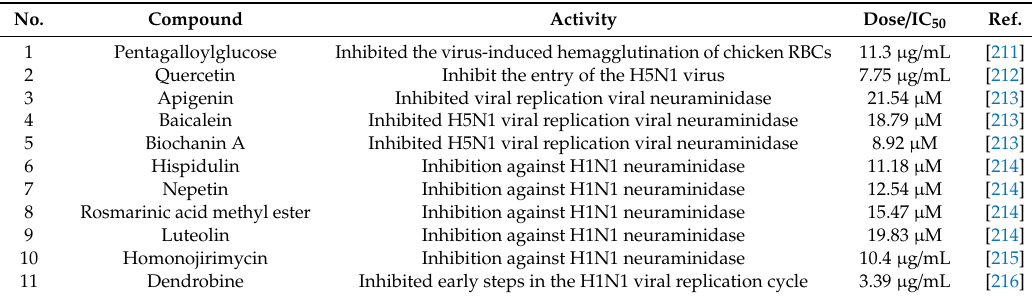
Table 6. Bioactive compounds derived from plants with anti-flu